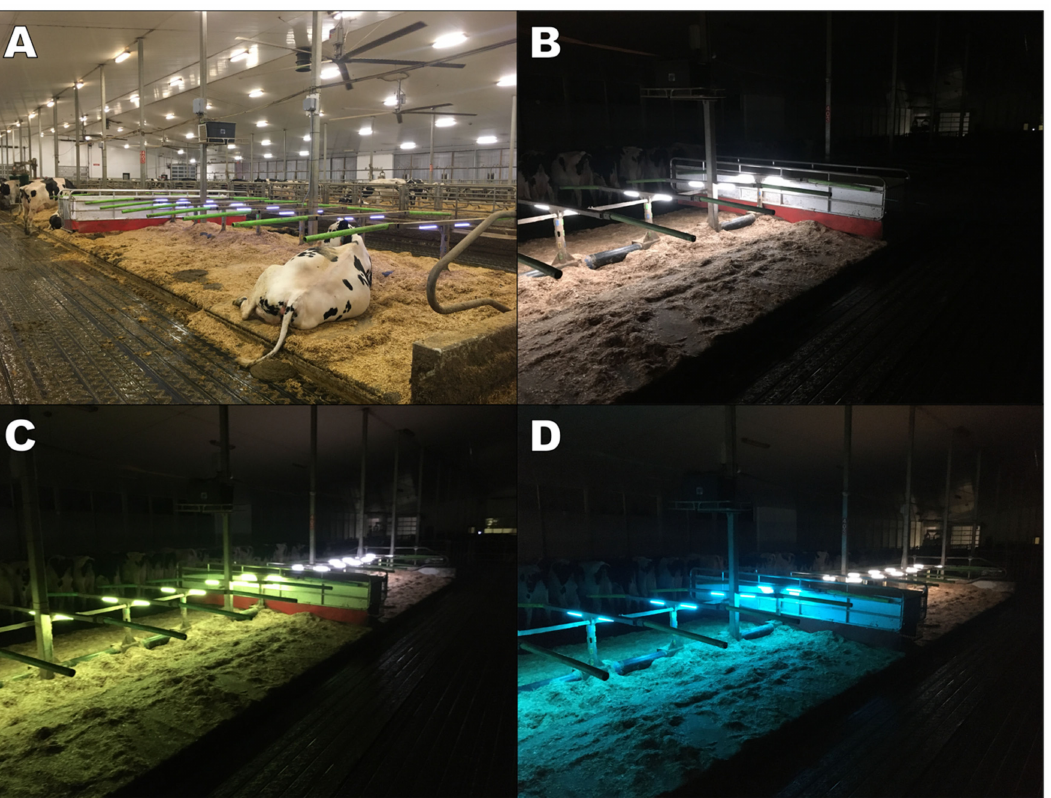
Figure A1. The experimental free-stall platform was divided into 2 halves using an opaque divider, resulting in 28 stalls available for 14 cows ( A ). The lights were programmed separately for each side. Pictures ( B – D ) show the light colours during the time period when only the LED lights were on (i.e., facility lighting was off). White light (380–780 nm) was tested against no LED light in week 1 ( B ). During week 2, yellow-green light (554 nm) was tested against white light ( C ) and during week 3, blue light (483 nm) was tested against white light ( D ).